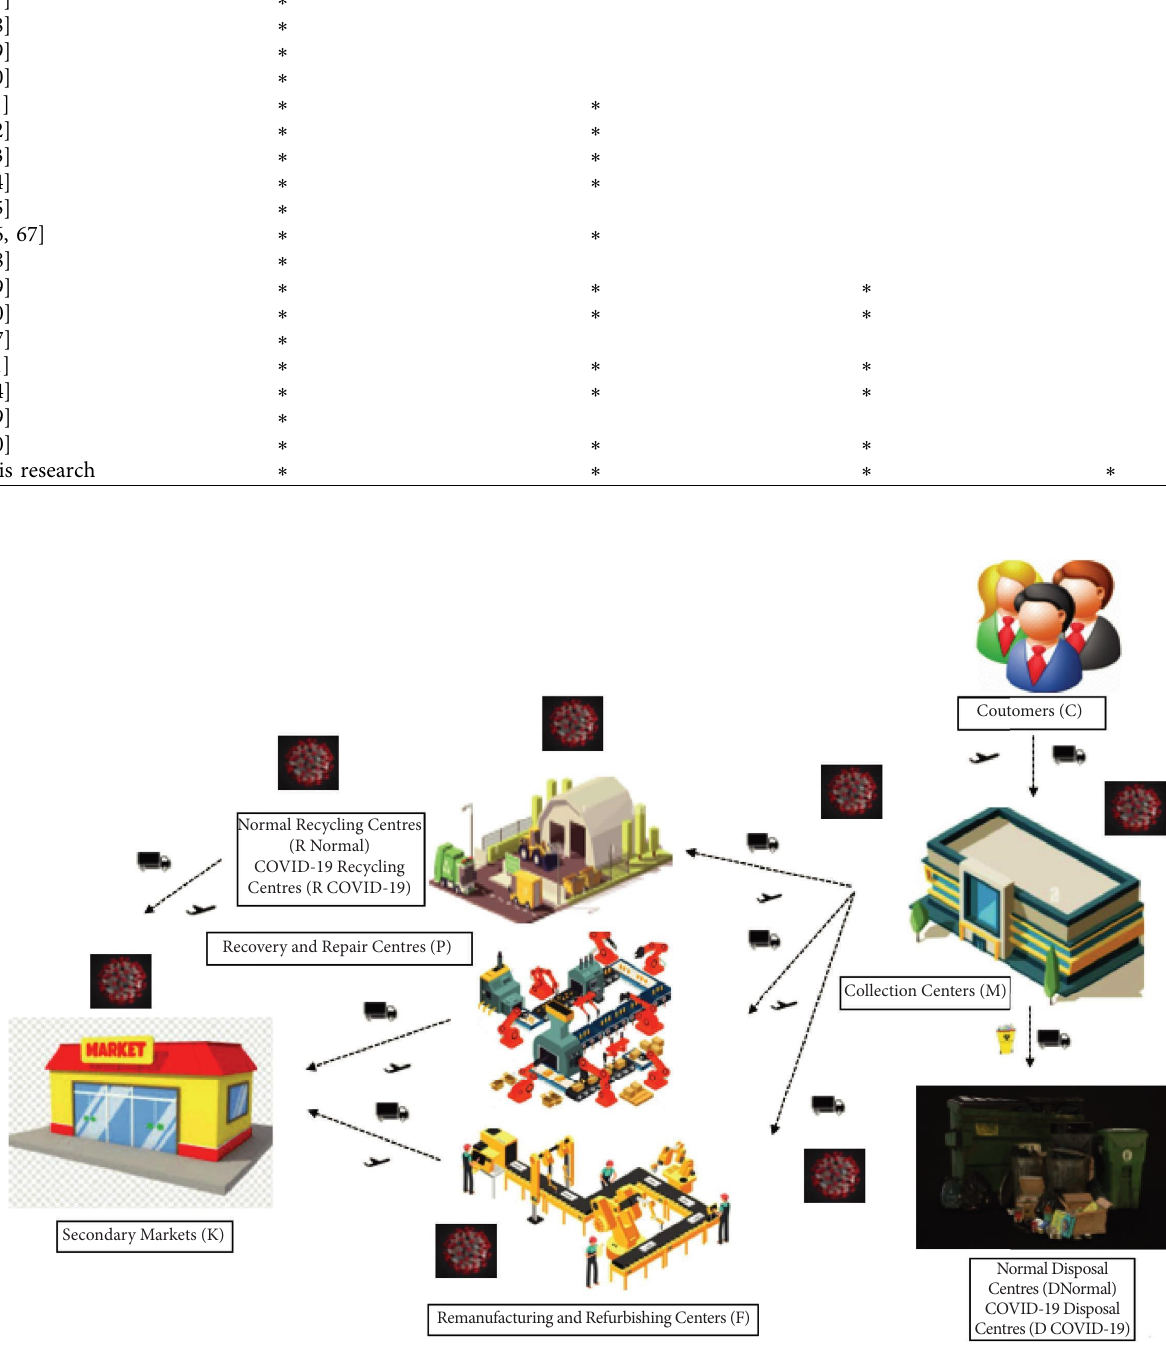
Figure 2: The RN between echelons during the